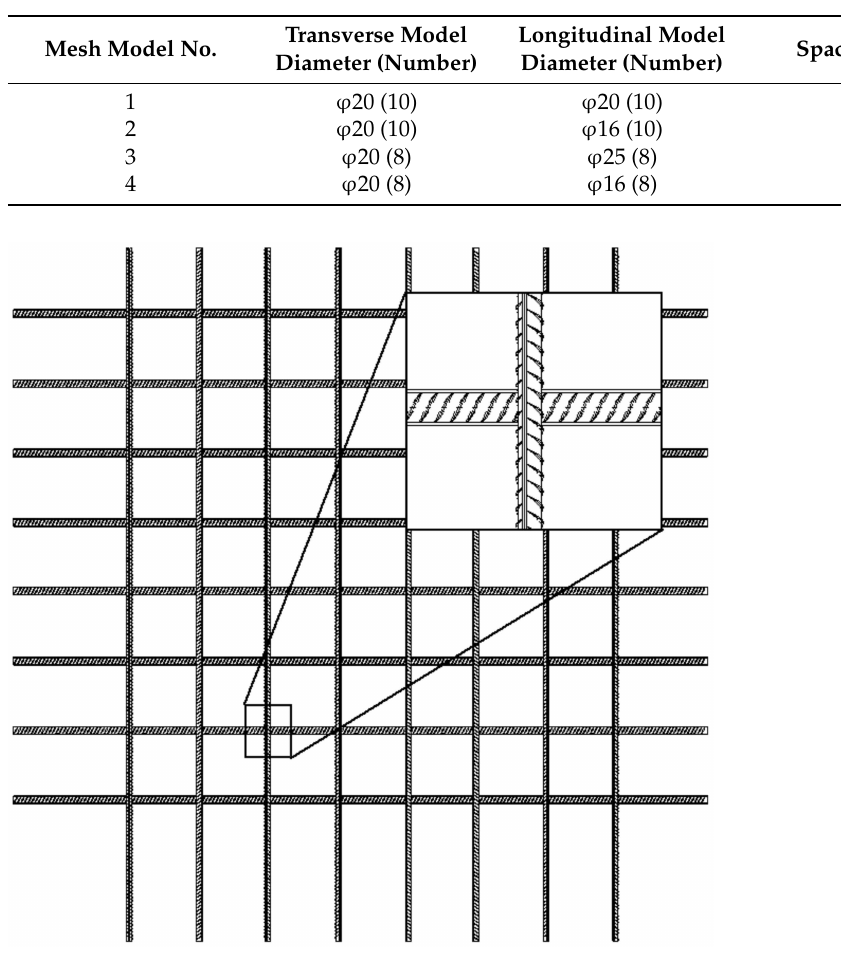
Figure 2. Surface and cross-sectional shape of rebar. Table 1. Parameters of the rebar mesh model.